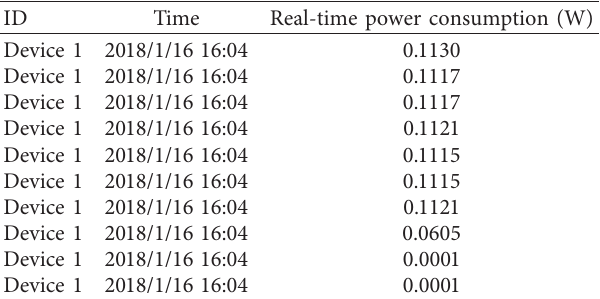
Table 11: Real-time power consumption of device